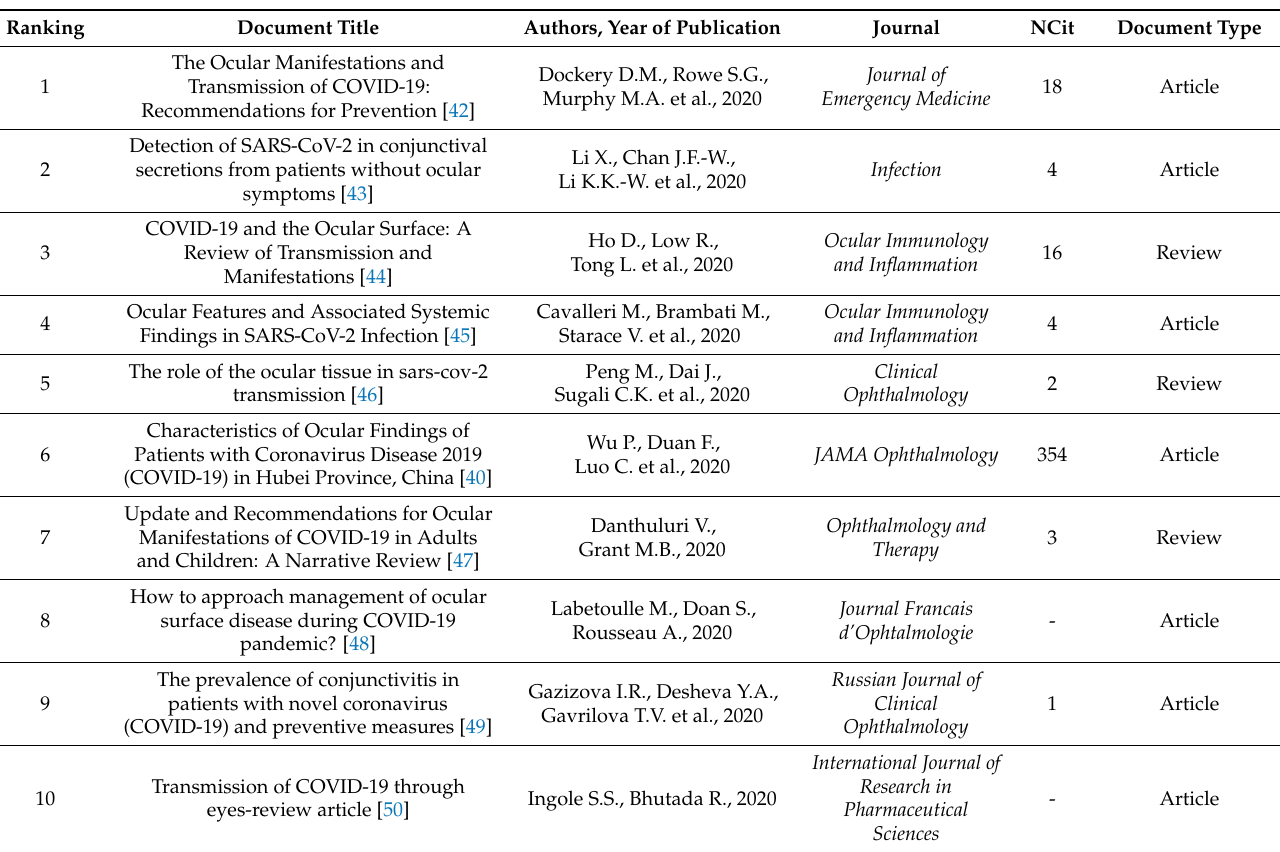
Table 5. Top 10 most relevant articles (Scopus) in the eye-related COVID-19 literature (2019–2021). Data retrieved in 16 March